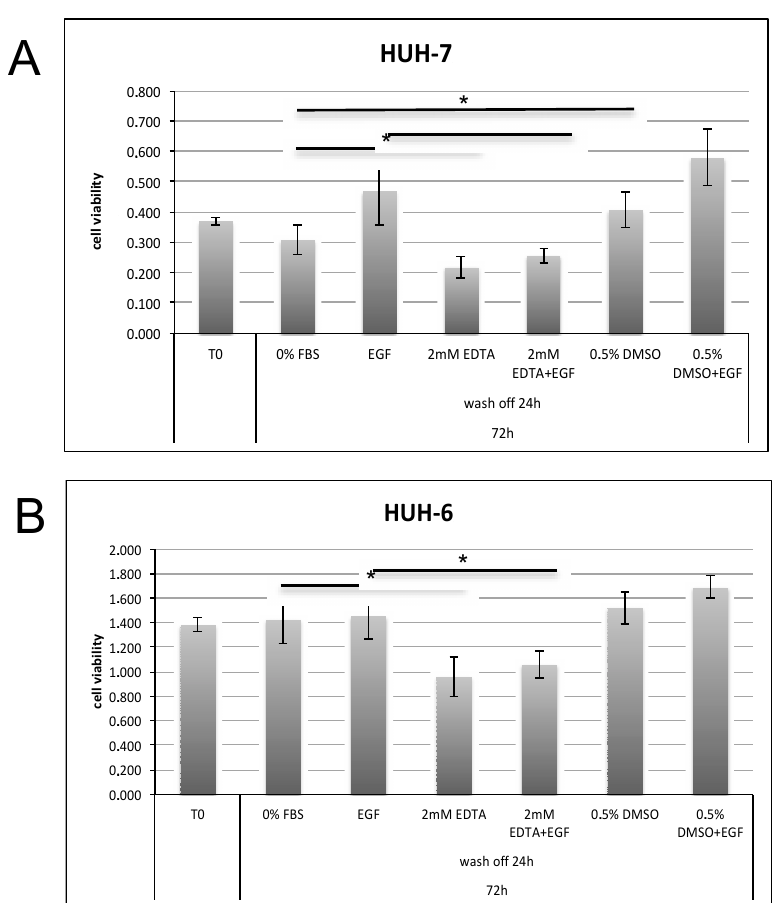
Figure 5. Starved HUH-7 ( A ) and HUH-6 ( B ) cell lines (T0) were left untreated (0% FBS as CTR) or treated with 100 ng / mL EGF, 2 mM EDTA, 0.5% DMSO or combined compounds (as indicated in the graphs) for 24 h. After 24 h of treatment, medium was replaced and cells were maintained in culture for a further 48 h in serum-free medium (0% FBS) with or without EGF, on the basis of the previous treatment. The proliferative capability of the cells was evaluated after a total time of 72 h. p value < 0.05 (*) .